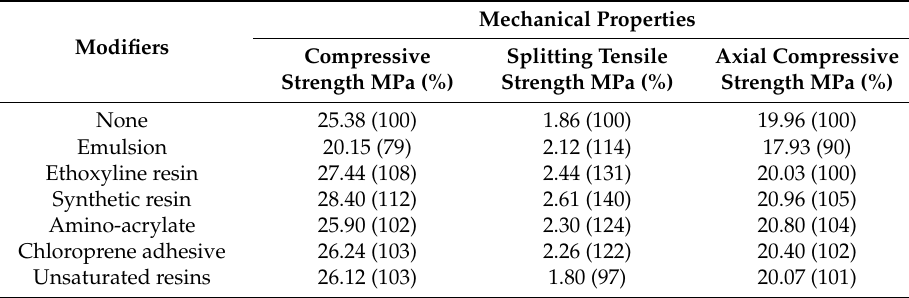
Table 4. Mechanical properties of modified crumb rubber concrete.